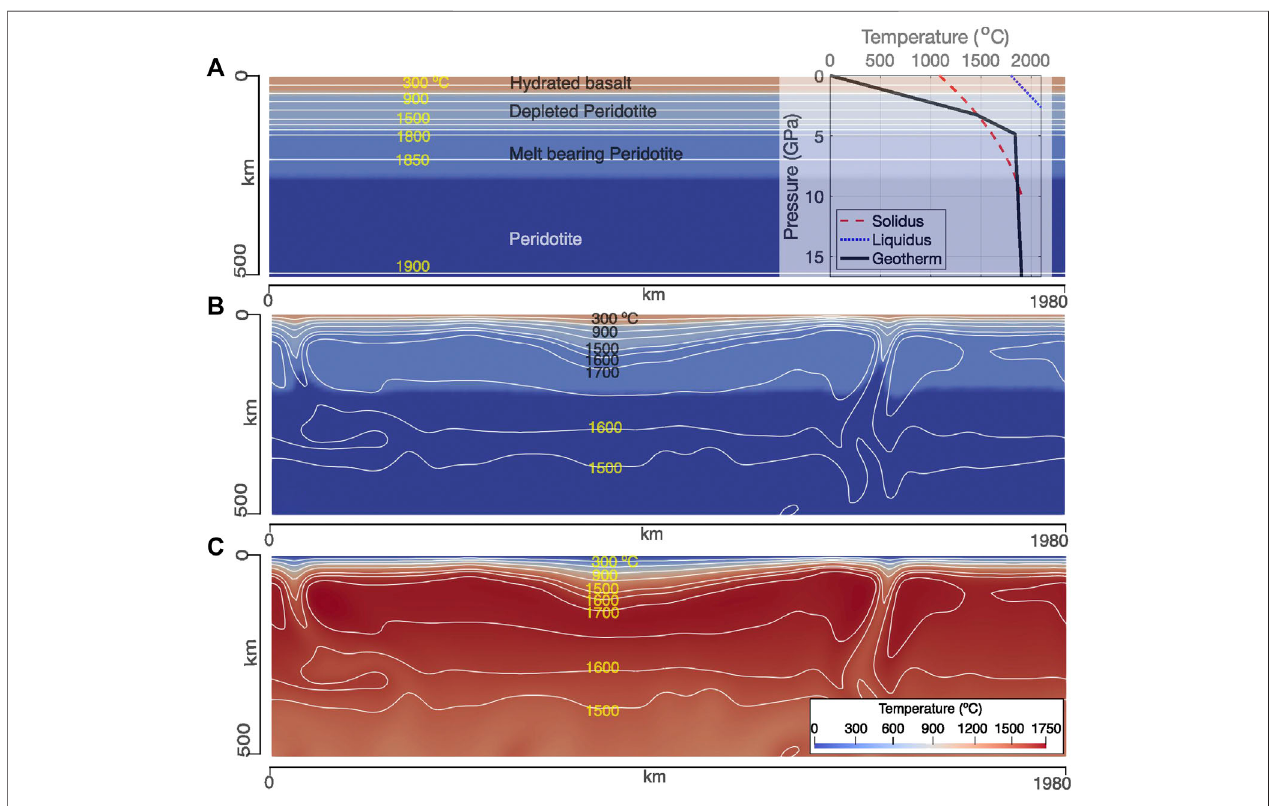
FIGURE1| (A) The initialcompositional setupused toreach astate ofstable mantle convection. The geotherm corresponds toamantle T p of1,600 ° C and mantle adiabat of 0.5 ° C/km. The thickness of basaltic crust is de fi ned by a Moho-T of 600 ° C. (B,C) The compositional and thermal pro fi le derived after a stable mantle convectionpattern isestablished.Thelithologicalparticlesin (B) hasbeen rede fi nedusingthethermal pro fi leshownin (C) .Thisstageisconsidered asthestartofmodel evolution for calculating the volume of tonalite-trondhjemite-granodiorite crust.